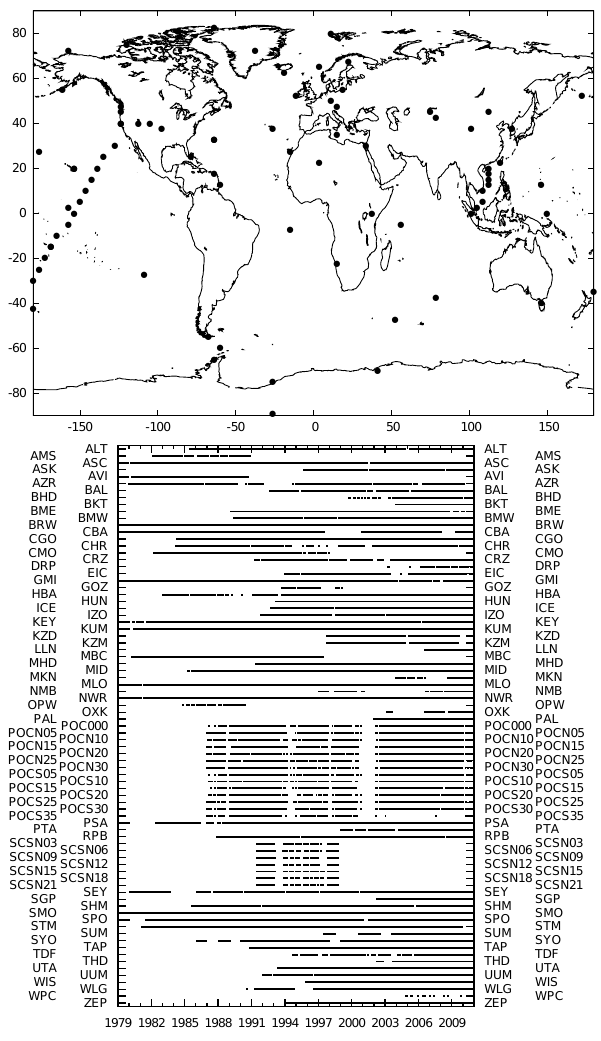
Fig. 1. Location of the NOAA ESRL flask measurements used in this study (a) and measurement availability at each site (b) . In (b) , the sites are designated by their identifier in the NOAA database.